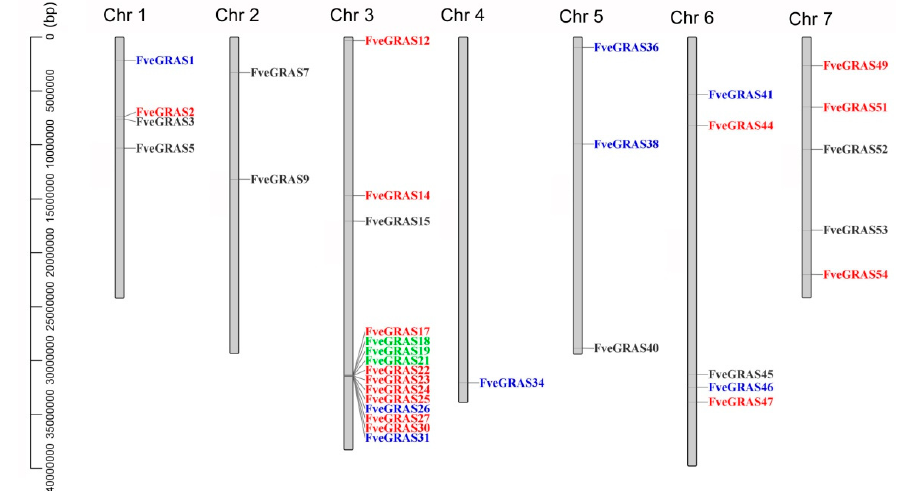
Figure 7. Chromosomal positions of woodland strawberry GRAS genes that respond to cold and / or heat treatments. Fifteen up-regulated genes and eight down-regulated genes both in cold and heat treatments are indicated by red and blue fonts, respectively. Nine genes with increased expression in cold stress, but decreased expression in heat stress are indicated by black fonts, and three genes with decreased expression in cold stress, but increased expression in heat stress are indicated by green fonts.